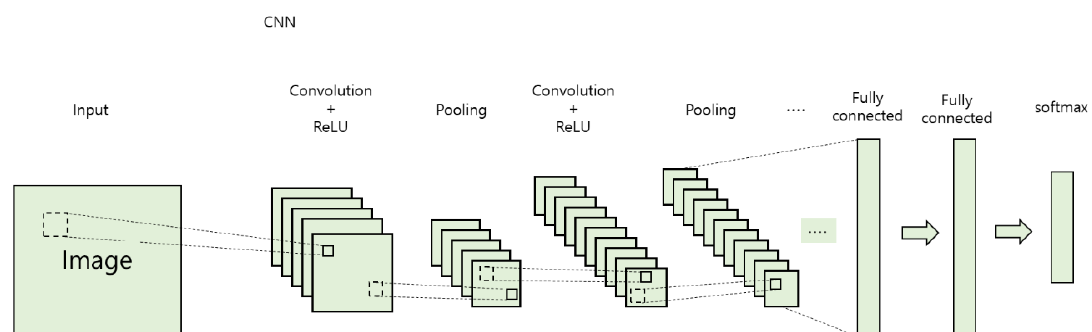
Figure 3. Structure of CNN.